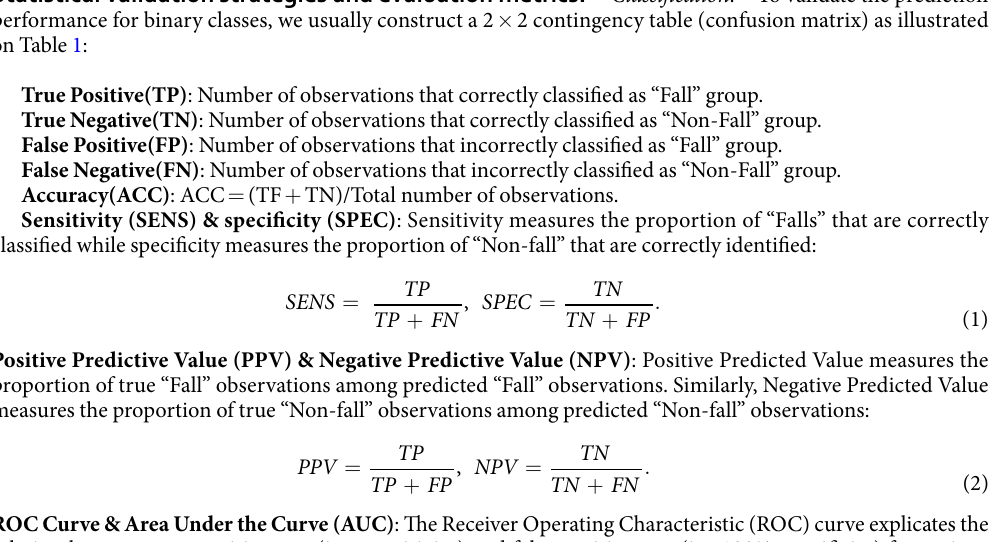
subjects’ demographics, PET, behavioral and sensory assessments, Mattis Dementia Rating Scale, sleep question- naires, genetics, number of falls, clinical measures and MR neuroimaging (207 variables in total). Among the 225